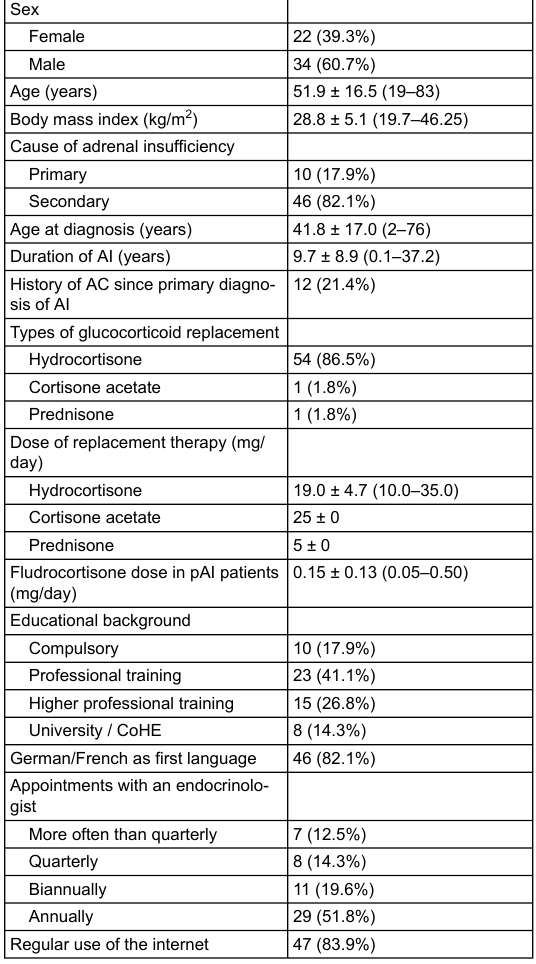
Table 3: Characteristics of 56 patients with adrenal insufficiency.